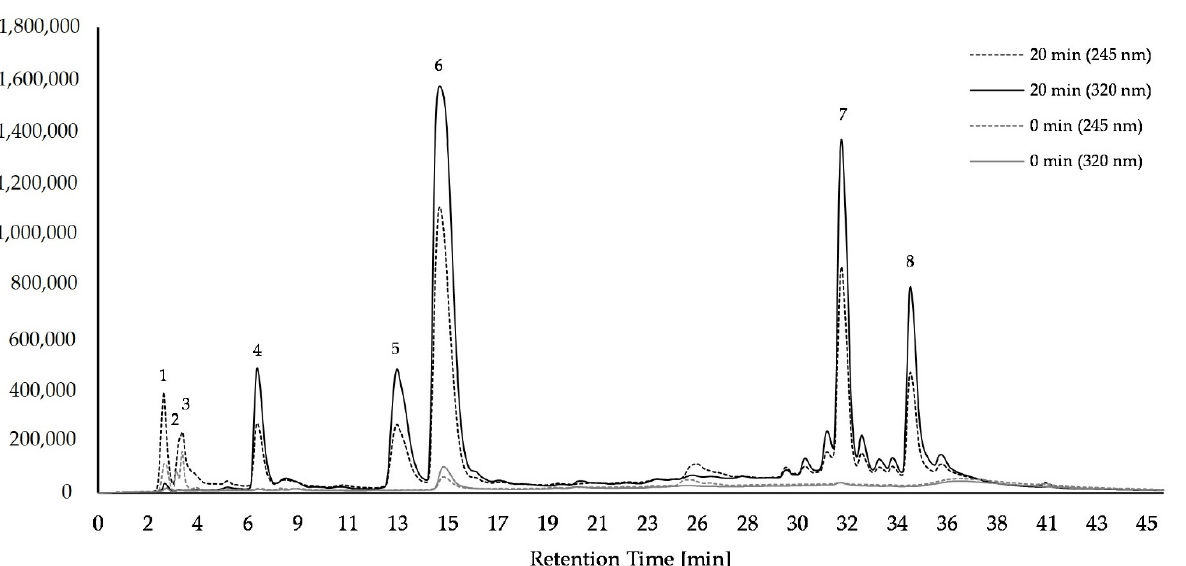
Table 1. Mineral content in mg per 100 g fresh weight (fw) of collected Urtica dioica L. and Aegopodium podagraria L. samples (n = 3), and the differences between them. Minerals